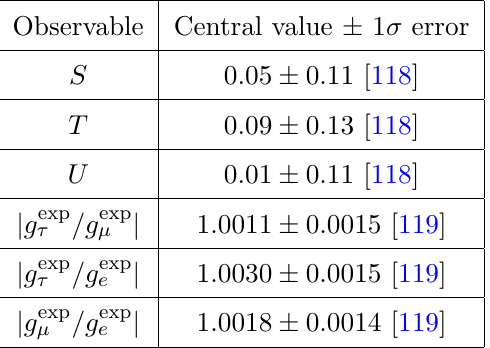
0 : 59, and (cid:26) TU = 0 : 83 (cid:0) (cid:0)